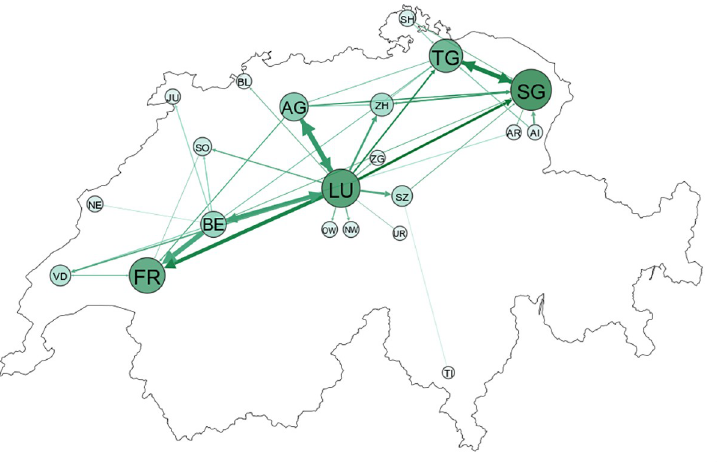
Fig 4. Significant flows of pigs between cantons in 2017. Only flows of 5,000 or more pigs are shown and transports to slaughterhouses are excluded. The size of a node depends on the number of pigs arriving in this canton. St. Gallen (SG) is the largest arrival canton with 131,776 pigs being transported to St. Gallen during the course of 2017. The largest flow of pigs (45,403) occurred between Luzern (LU) and Aargau (AG). The abbreviations for cantons are given in S1